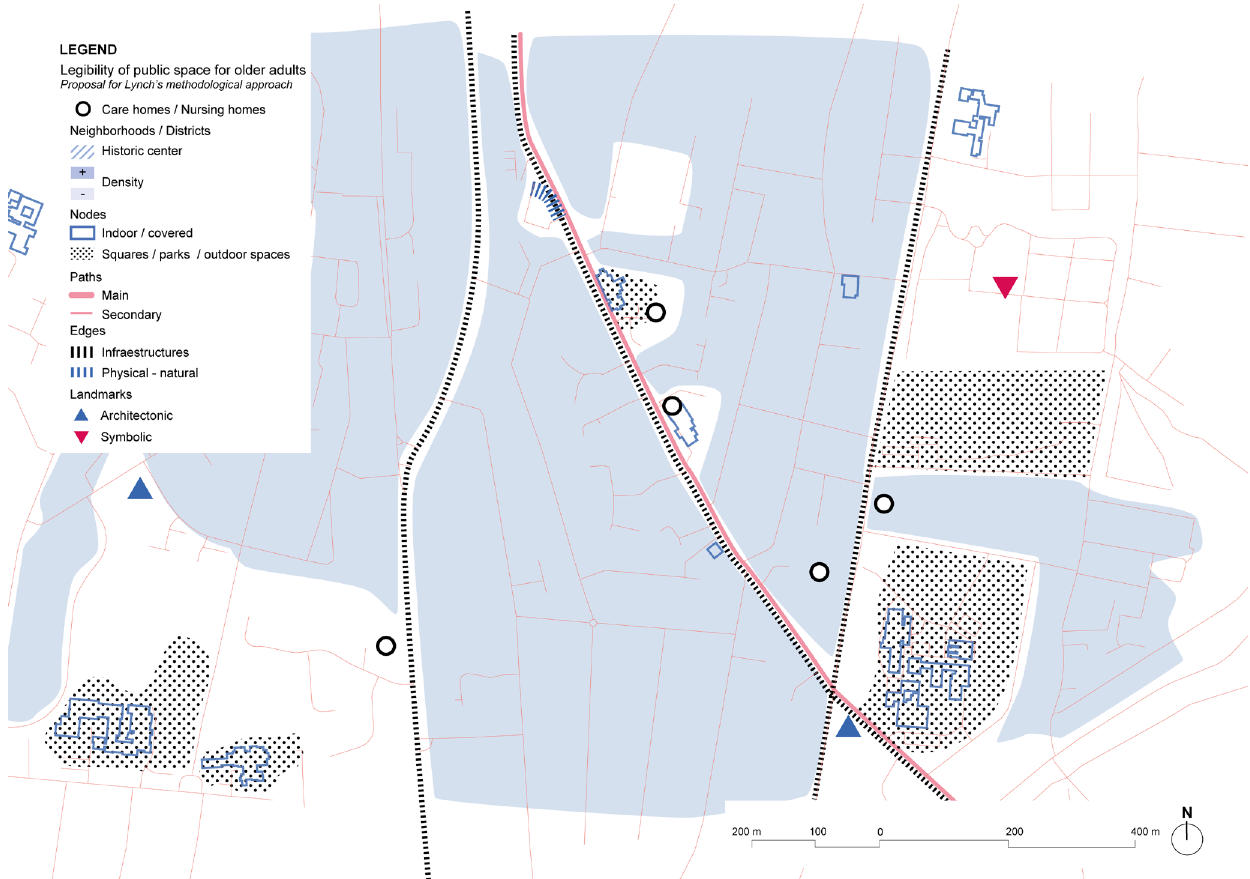
Figure 10. Harmony House and its immediate surrounding’s scheme based on Lynch’s theory. Source: Own